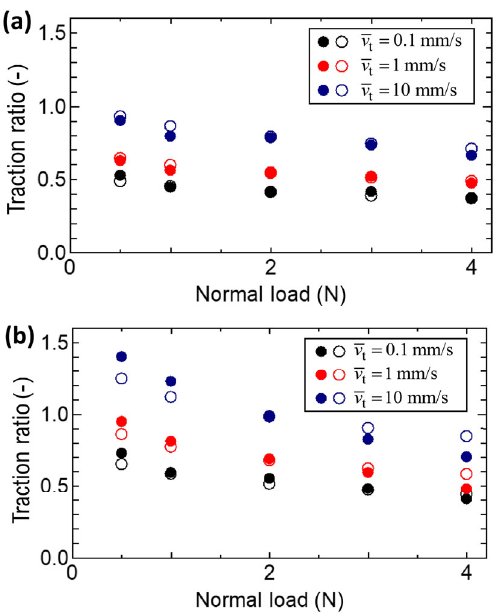
Fig. 12 Comparison of pressure-dependencies of traction ratio for two types of surface roughnesses. The traction ratios are evaluated by averaging the values in the steady sliding state. The prescribed sliding velocity (driving speed of the PMMA plate) is set to be 0.1, 1.0, and 10.0 mm/s. (a) and (b) show the results for specimens I and II, respectively. The closed and open circles show the results of the experiment and friction model,